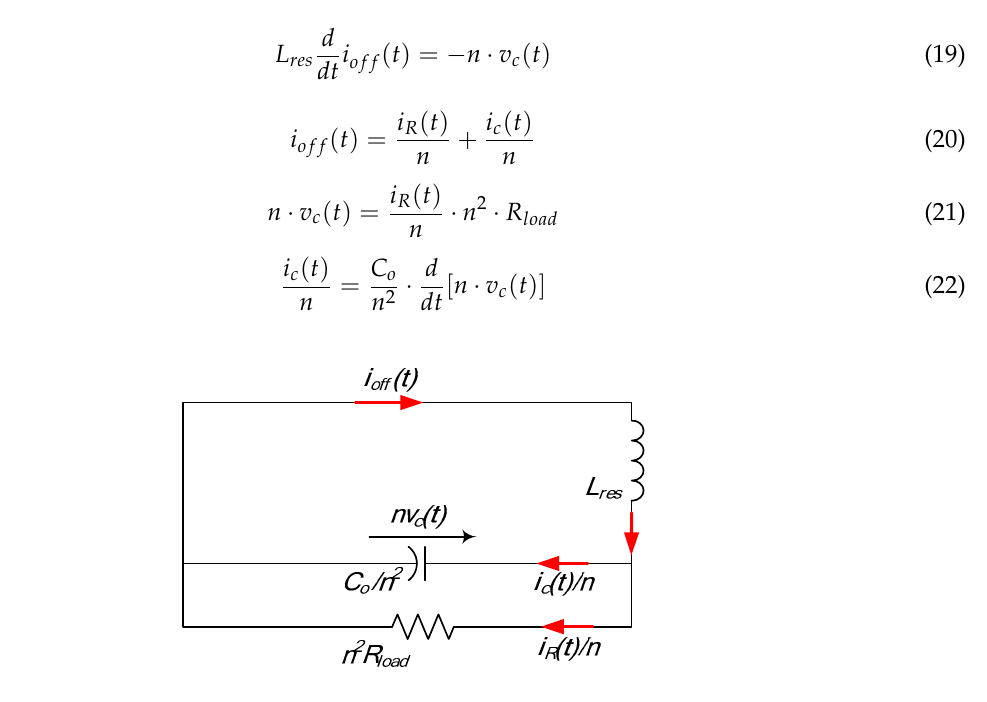
Figure 6. Equivalent Circuit of the Freewheeling Stage.